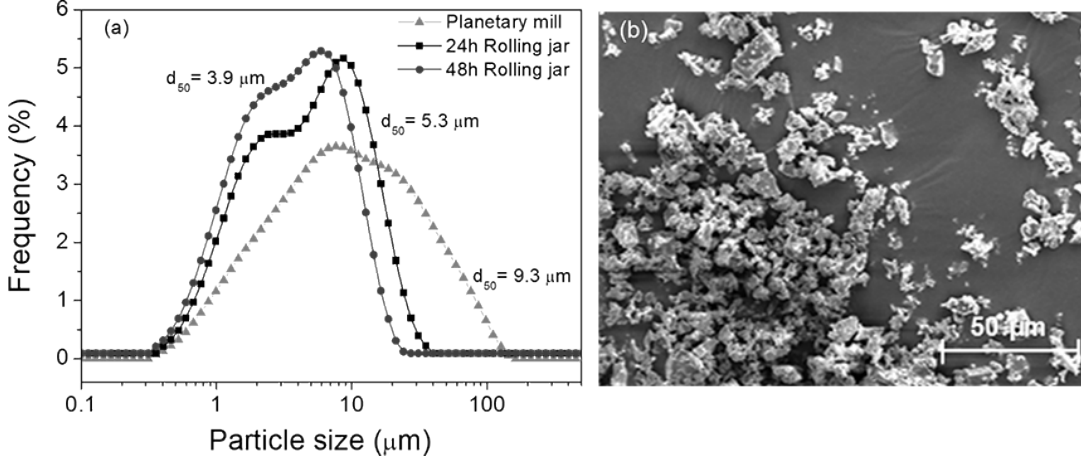
Figure 2. (a) Particle size distribution curves of the glass powders obtained from different milling processes exhibiting their respectives d values; (b) SEM micrograph of the glass powder resulting from the final milling (48 50